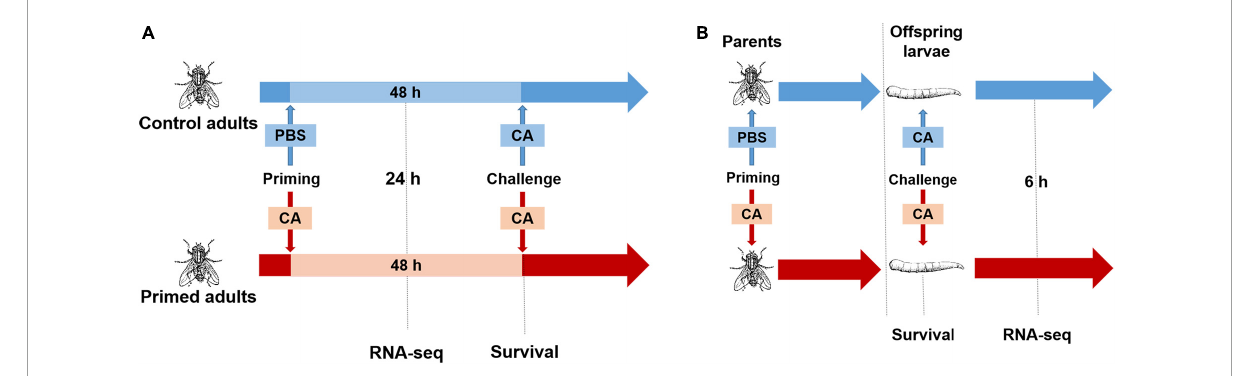
FIGURE1 Experimental design. (A) Within generation immune priming. Housefly adults were primed by injection of heat-killed C. albicans or PBS as the control. Samples were collected at 24 h post-priming for RNA-seq. At 48 h after priming, adults were challenged with a lethal dose of C. albicans , and the survival was monitored after the challenge. (B) Trans-generational immune priming. Parental adults were primed by injection of heat-killed C. albicans or PBS as control, then mated and laid eggs, when offspring reached the third instar, larvae were challenged with a lethal dose of C. albicans , survival was monitored after the challenge, and samples were collected at 6 h post-challenge for RNA-seq.